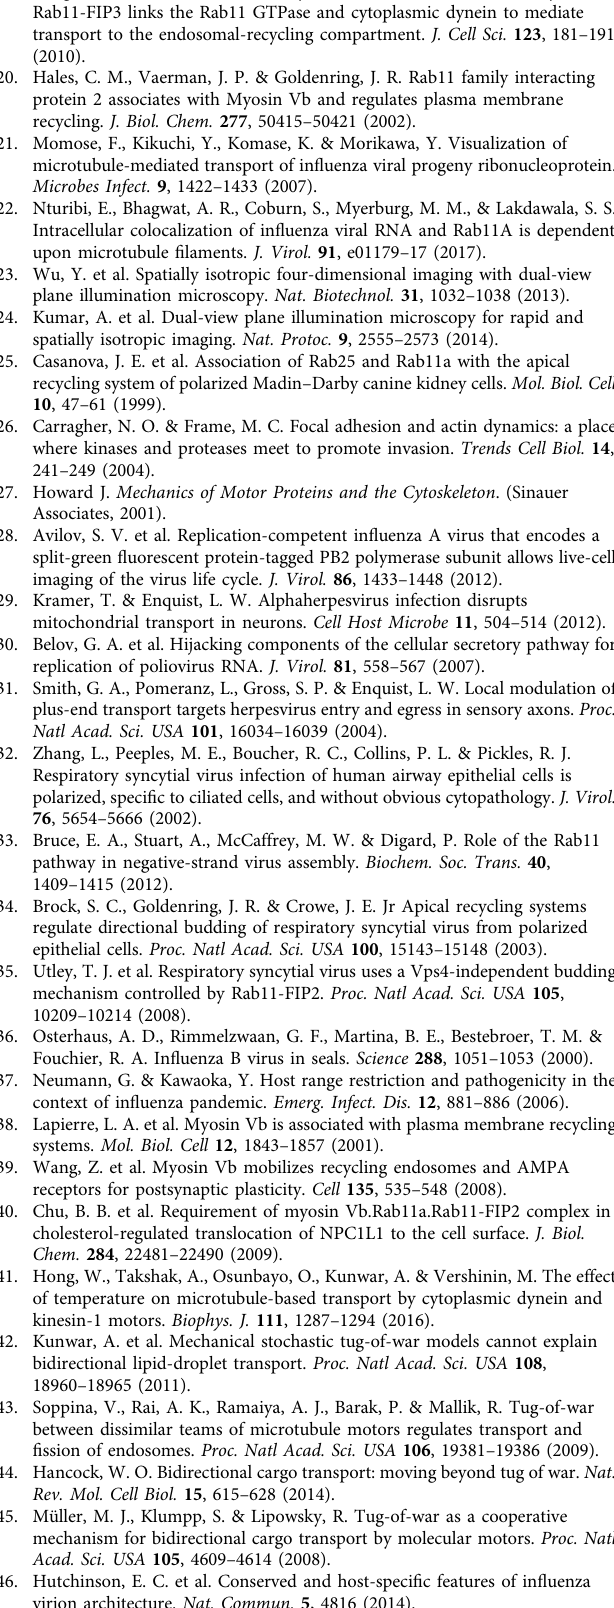
Table 1. Data underlying Fig. 7b, c are provided as Supplementary Data 1 fi le. Mass spectrometry proteomics data have been deposited to ProteomeXchange Consortium (http://proteomecentral.proteomexchange.org) via the PRIDE partner repository 69 with the dataset identi fi er PXD016331 or at